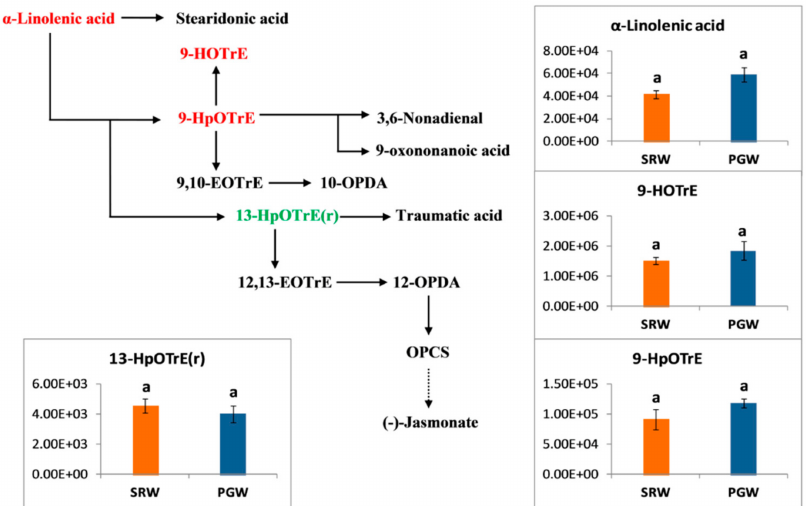
Figure 8. Y -axis shows the differences among the metabolites’ relative contents linked with a linolenic acid pathway from mature fruit of pumpkin-grafted watermelon (PGW) and self-rooted watermelon (SRW). Red or green color shows the higher content of amino acids in mature fruit of PGW or SRW, respectively. Vertical bars represent standard error among three independent replicates. Data are the mean ± SE of three replicates. Different lowercase letters indicate significant differences at p < 0.05.